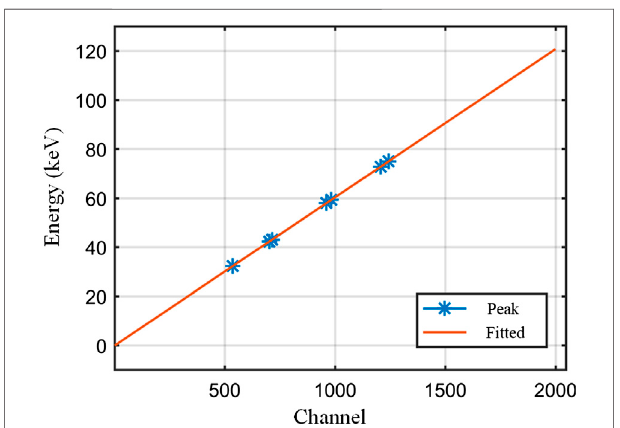
Frontiers in Physics |